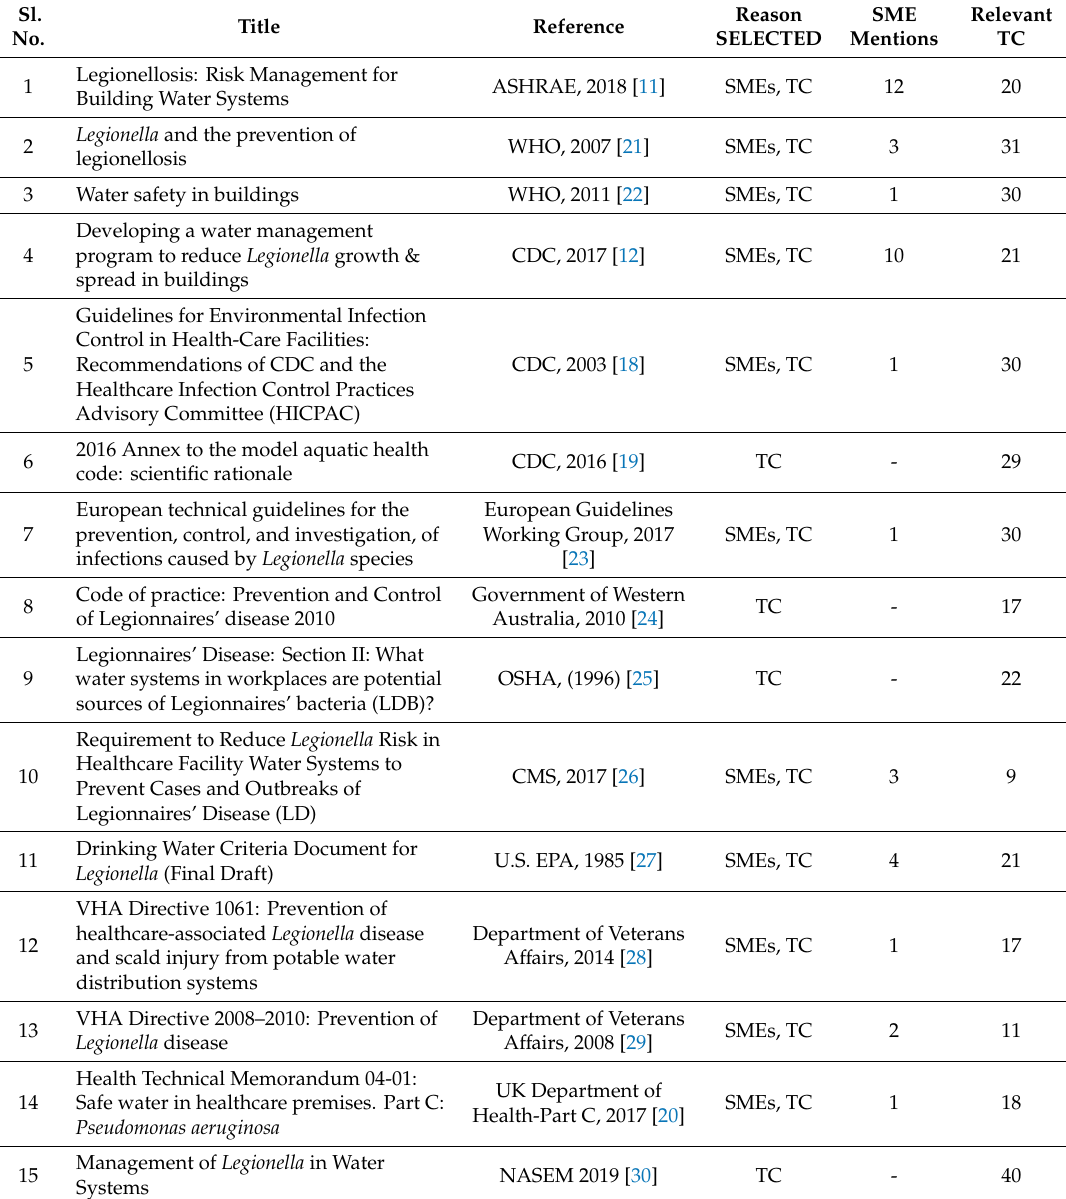
Table 1. List of important guidelines documents (IGDs) identified using subject matter expert (SME) recommendations and topic coverage (TC; see text for a description of how counts were developed). Sl.